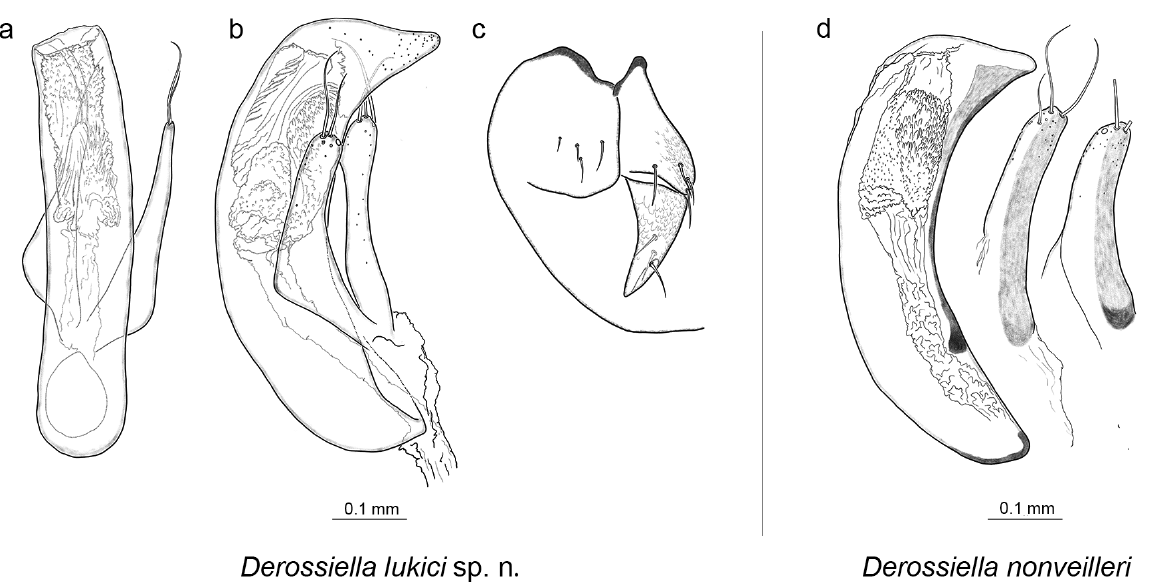
Figure 5. Male and female genitalia of Derossiella representatives: aedeagus of D. lukici sp. n., dorsal view (a) ; and lateral view (b) ; female genitalia gonocoxite 1 and 2 (basal and apical segments of gonostylus) copulatory piece of D. lukici sp. n. (c) ; and D. non- veilleri , lateral view of male aedeagus with parameres detached (d) (illustration by Fedor